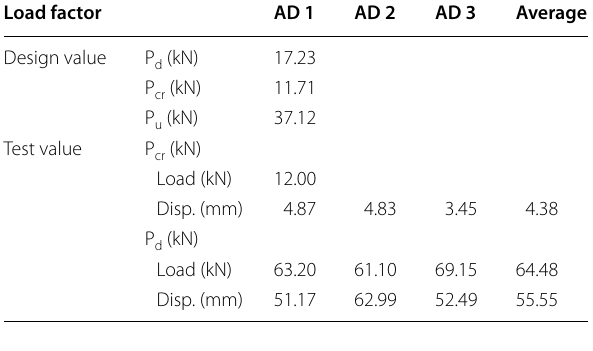
Table 4 Test results of load–displacement (AD).